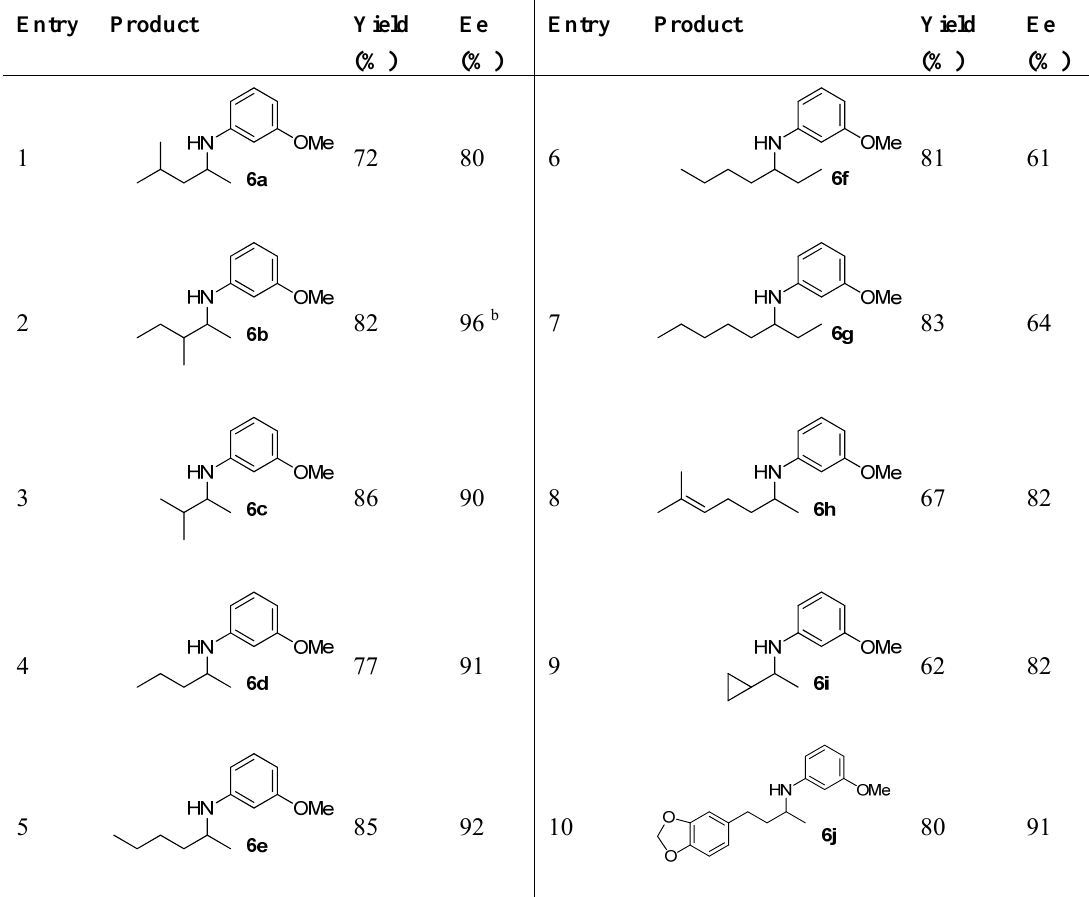
Table 3. DARA with m -substituted anilines.